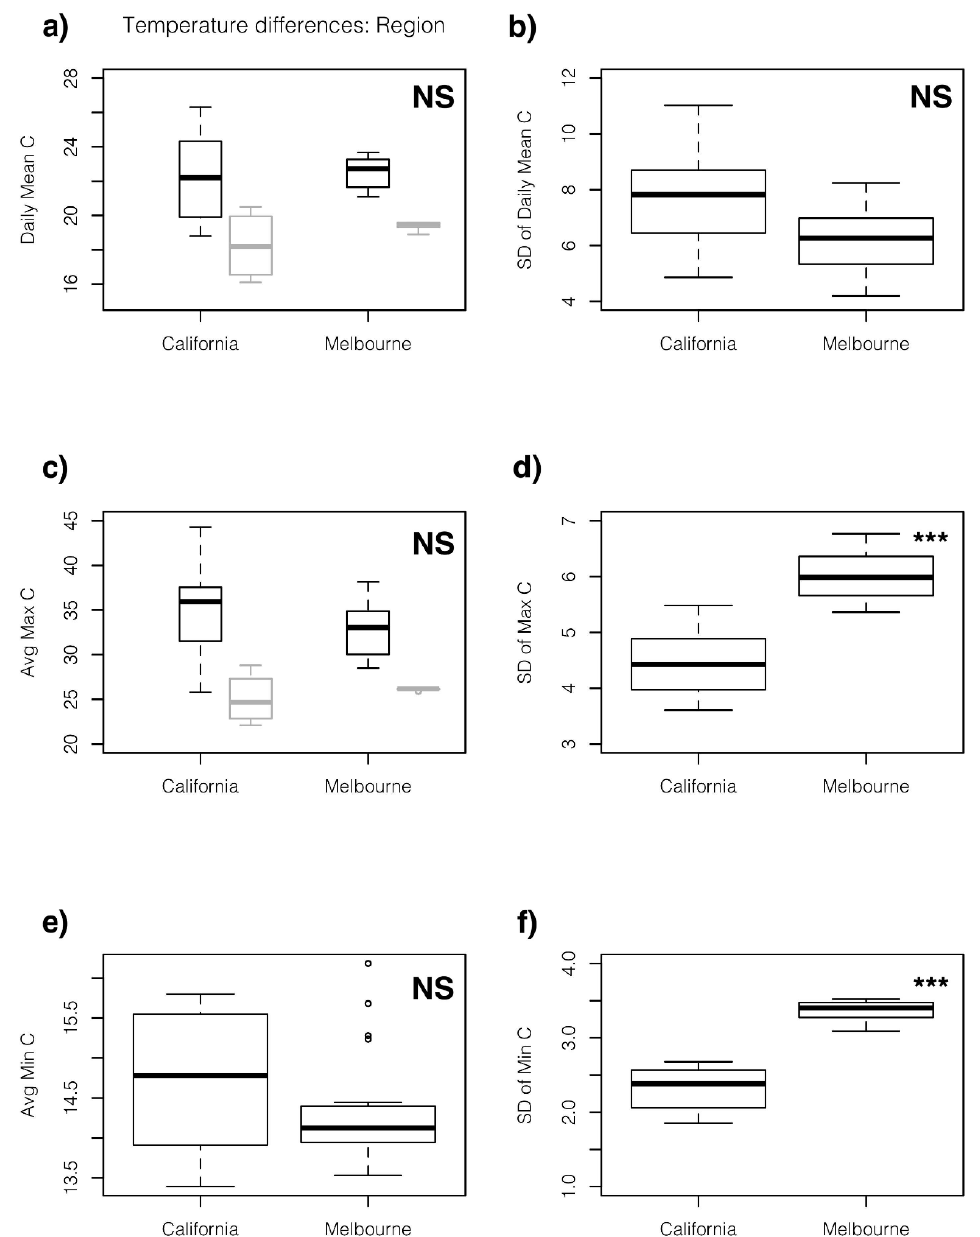
Figure 2. Average, maximum and minimum temperatures and their variation as measured by standard deviation (SD) observed in the gardens over the study period for the regional models ( a – f ). In gray, available WorldClim v2 Bioclim data plotted for a context of long-term temperature averages ( a , c ). WorldClim data are the mean temperature of the warmest quarter (BIO9) ( a ) and the maximum temperature of the warmest month (BIO5) ( c ). Box-and-whisker plots of the grouped values indicate the median, maximum, minimum, and 75% and 25% quantiles. Circles indicate outliers. Significant differences between local-scale temperature measurements (from logger data) are denoted by asterisks (*** p < 0.001, ** p < 0.01,* p < 0.05) and no difference denoted by “NS”.